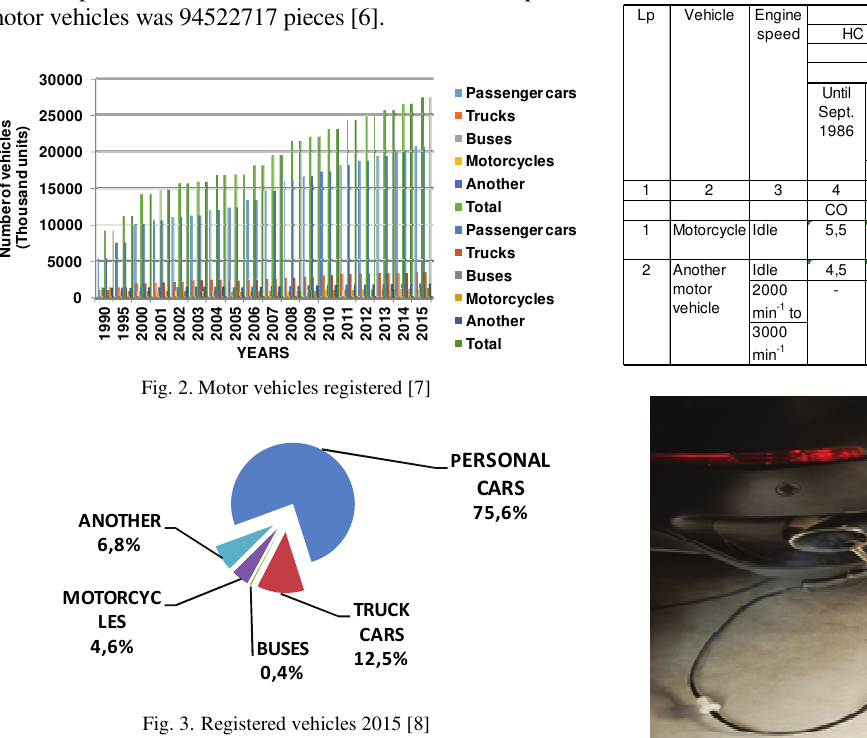
Table 1. Levels of gaseous pollutants and air excess coefficient λ [12]